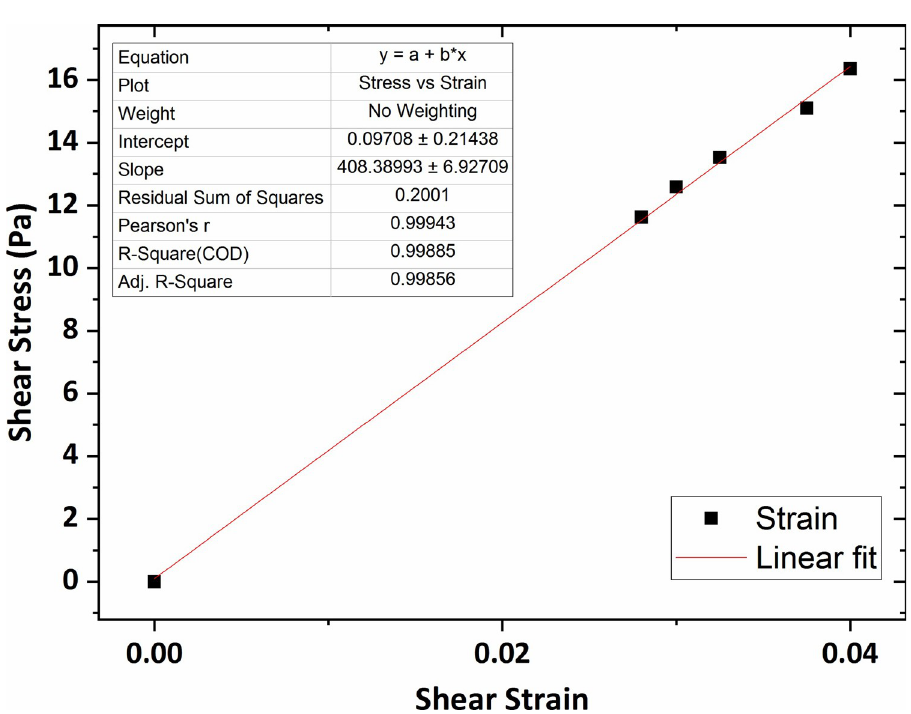
Fig 9. The graph of shear stress versus shear strain for the agarose gel of 0.4 wt % percent concentration.